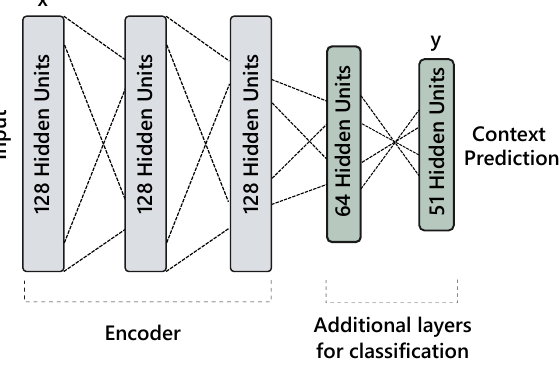
Figure 4. Illustration of an adversarial autoencoder (AAE) based classification